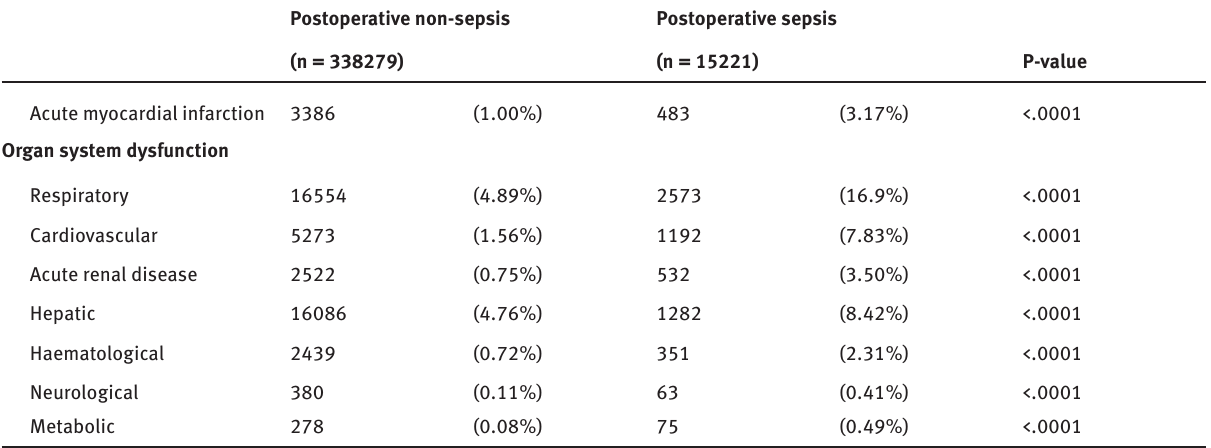
Table 1 continued : Basic characteristics of the study